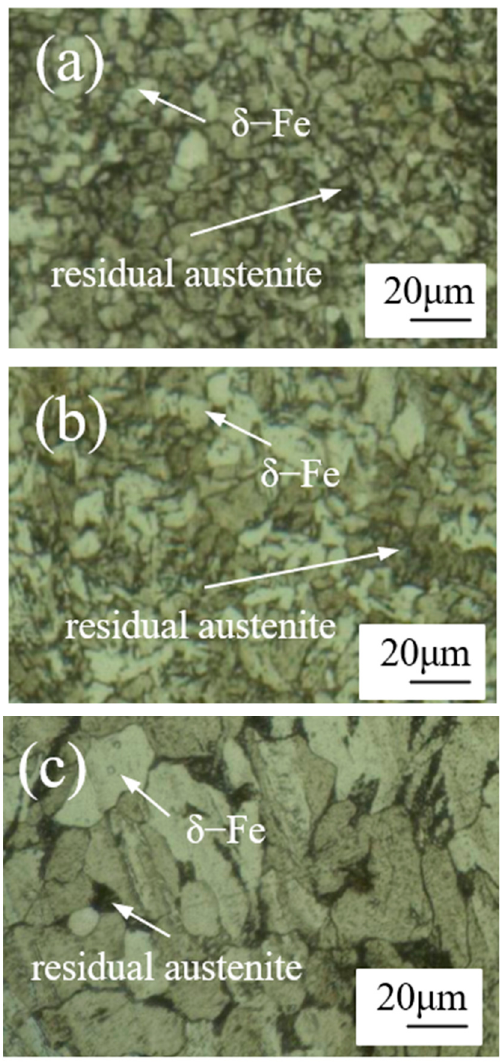
Figure 8. Optical micrographs of weld zone after welding process with different welding currents of ( a ) 150A for sample #1, ( b ) 160A for sample #2, and ( c ) 170A for sample #3.